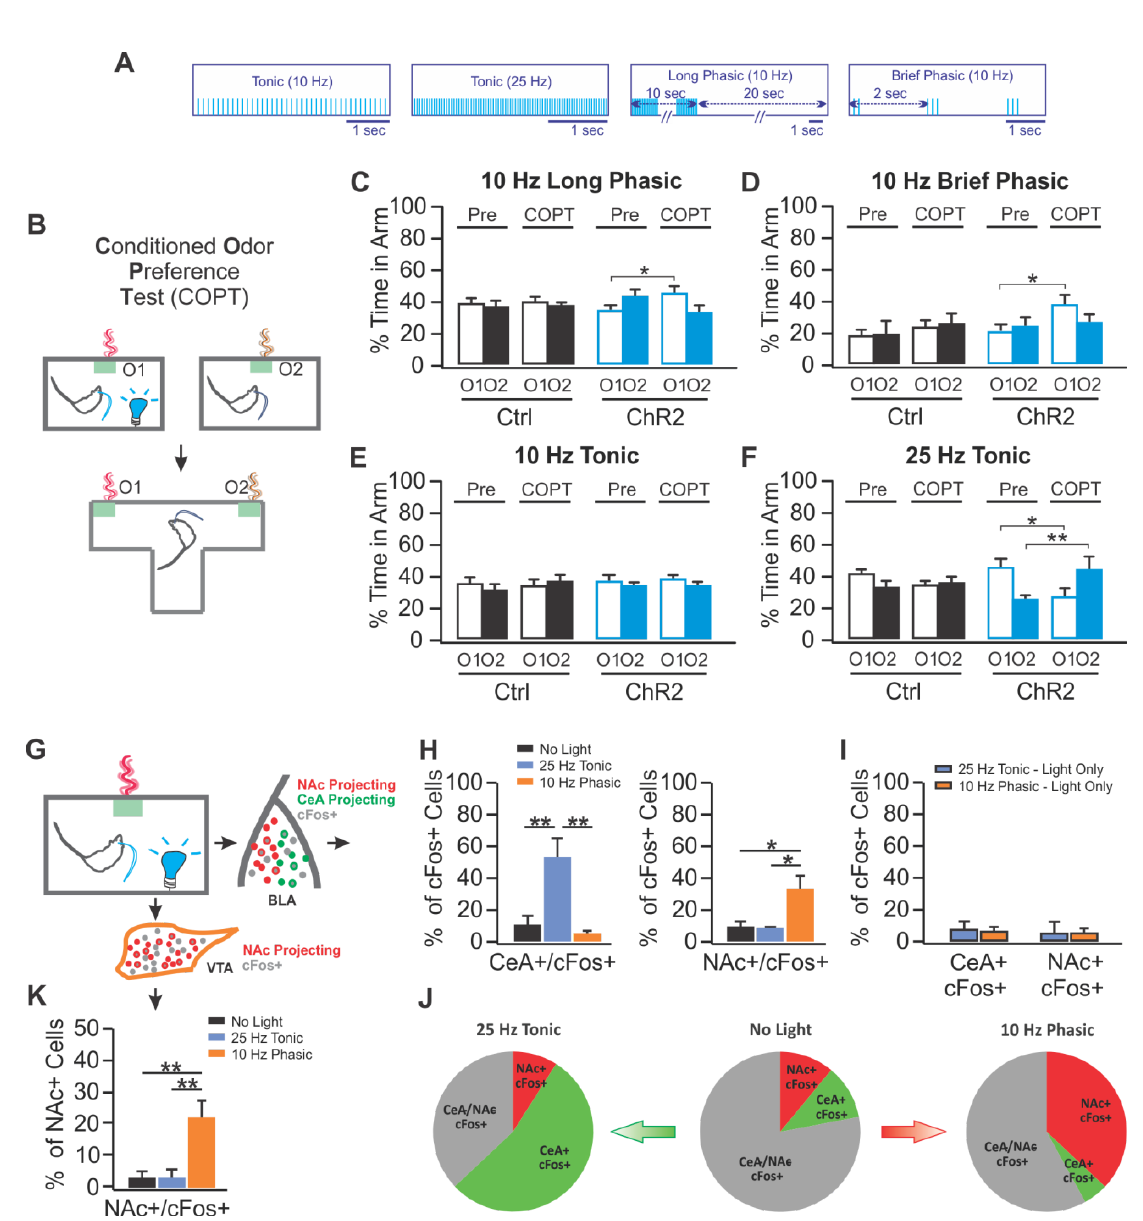
Figure 6. Phasic and tonic LC activations lead to differential valence odor learning. ( A ) The four blue light pulse patterns used to activate LC neurons. ( B ) Schematic for conditioned odor preference protocol. ( C ) A conditioned odor preference following odor pairing with long phasic LC (10 Hz for 10 s/30 s) ( D ) A conditioned odor preference following odor pairing with brief phasic LC (10 Hz for 300 ms/2 s). ( E ) No preference effect when pairing odor with 10 Hz tonic LC activation. ( F ) A conditioned odor aversion following odor pairing with 25 Hz tonic LC activation. ( G ). The protocol used for c-Fos studies. ( H ) The central amygdala (CeA) projecting neurons in the basolateral nucleus of the amygdala (BLA) were significantly activated by 25 Hz tonic LC activation paired with odor relative to no light and brief phasic LC activation controls. BLA neurons projecting to the nucleus accumbens (NAc) showed significant c-Fos activation relative to no light and 25 Hz tonic controls when odor was paired with phasic LC activation by 3 pulses of 10 Hz light/2 s for 10 min. ( I ) If only the phasic or tonic LC activation was given for the same period without a novel odor present, there was no difference in c-Fos neurons activated by the two patterns and relatively few c-Fos neurons were observed. ( J ) Pie charts showing the proportion of CEA (green) and NAc (red) projecting neurons as a fraction of the total set of c-Fos neurons (grey + green + red) observed in BLA with 25 Hz LC tonic + odor, no light + odor, and brief 10 Hz phasic LC + odor. ( K ) NAc-projecting neurons in VTA showed increased c-Fos with brief 10 Hz phasic LC + odor relative to no light + odor and 25 Hz LC tonic + odor groups. * p < 0.05; ** p < 0.01. Adapted with permission from [13] 2021 Creative Commons Attribution-Non-Commercial 4.0 International Public License (CC BY-NC